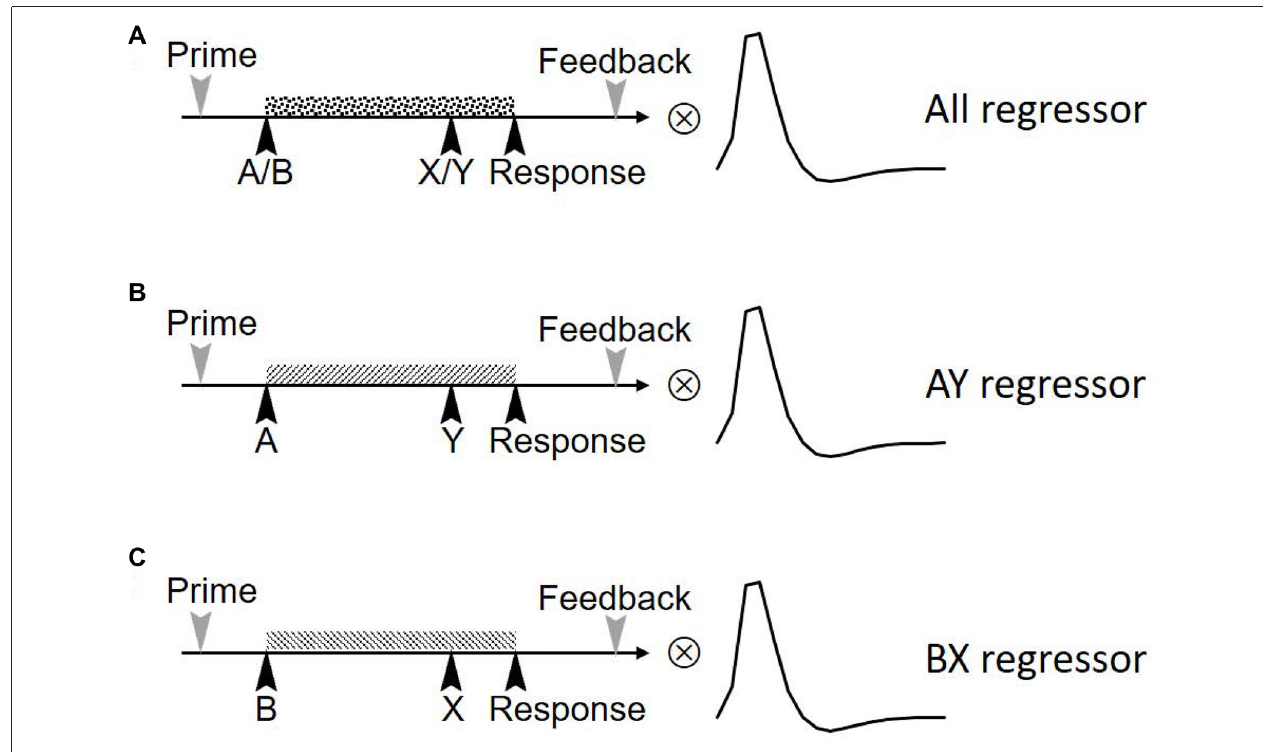
FIGURE 2 | Three regression factors for the task in the study. Three independent boxcar-shaped regression factors were set up. These three sequences represent the regression factors for (A) all trials (including AX, AY, BX, BY), (B) AY trials and (C) BX trials. The three sequences were convolved with statistical parametric mapping’s (SPM’s) hemodynamic response function (HRF) to form the final task sequence.